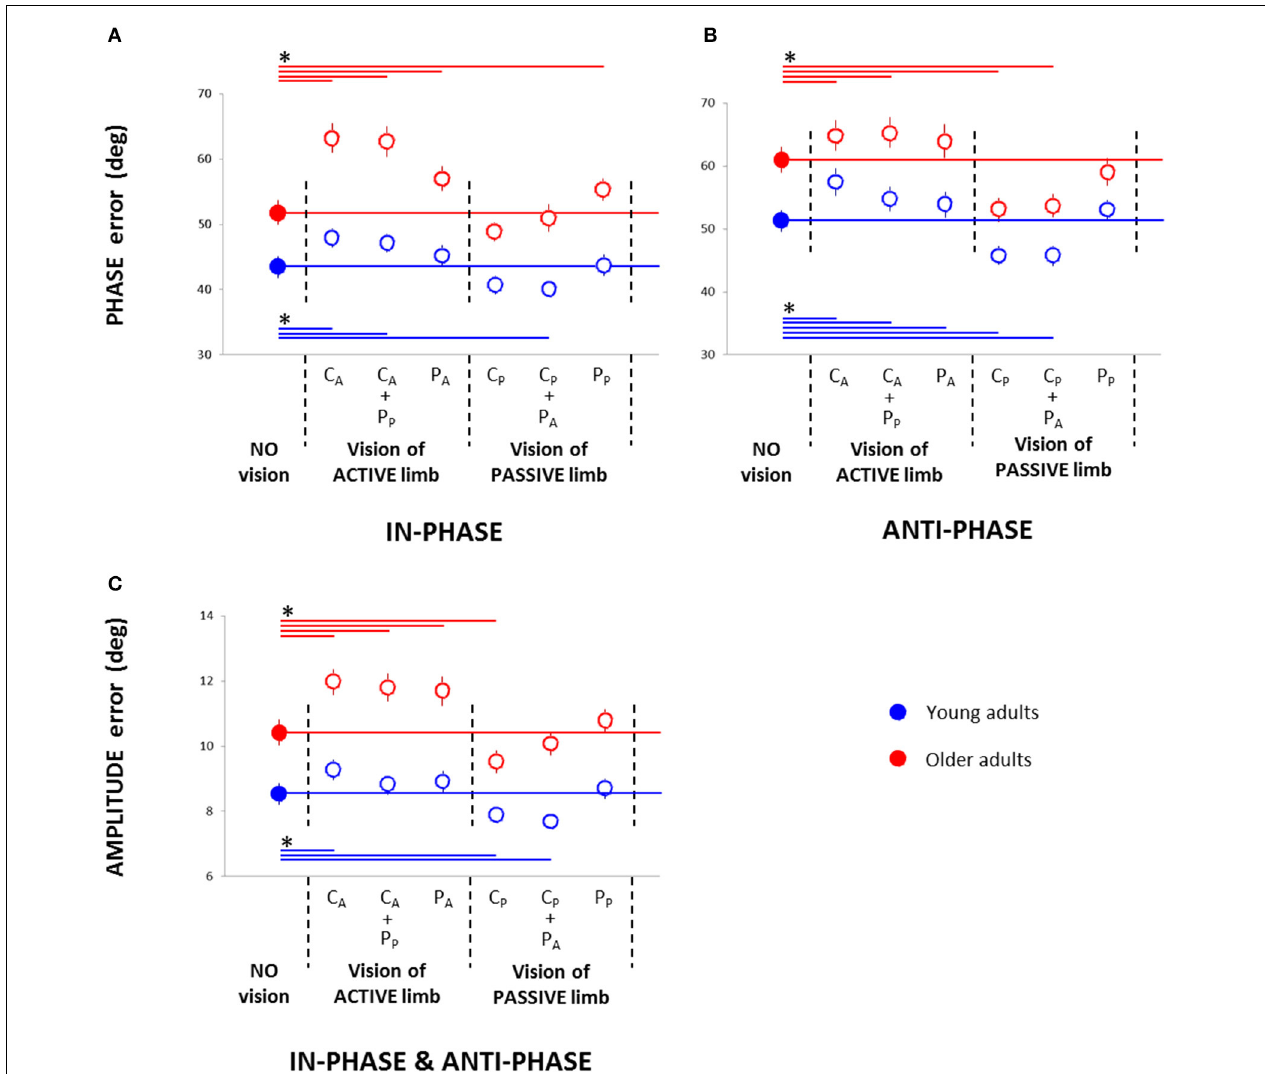
FIGURE 3 | Root mean square of the relative phase (phase error) in the in-phase (A) and anti-phase pattern (B) and root mean square of the amplitude error (C) in young and older adults in the seven conditions: no vision; central vision of the active wrist (C A ), central vision of the active wrist and peripheral vision of the